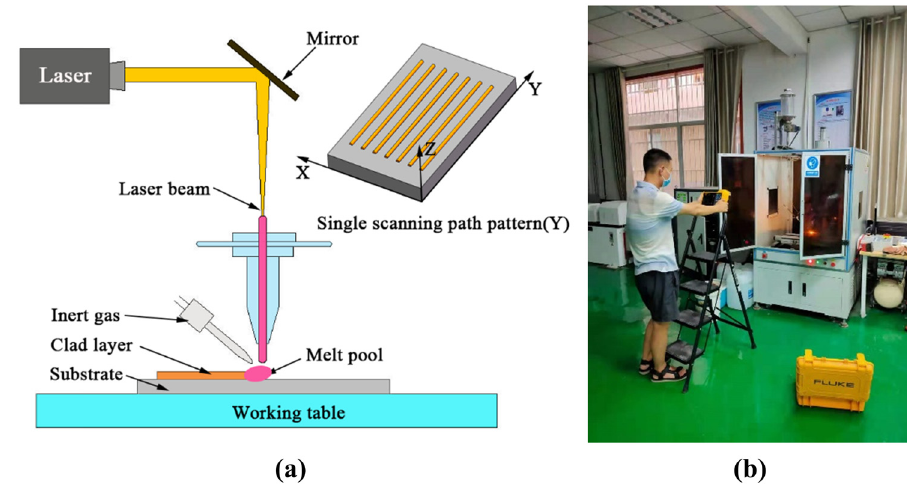
Figure 1: Schematic and actual photo of laser scanning process: ( a ) schematic diagram and ( b ) actual